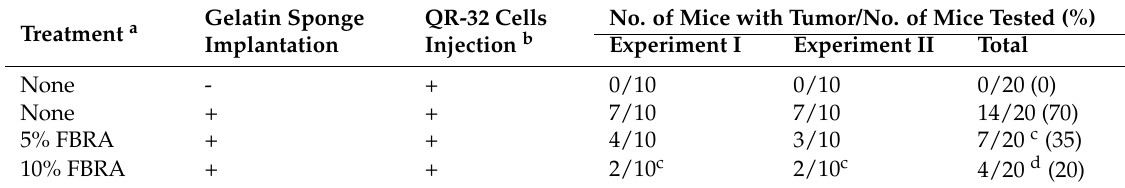
Table 1. Inhibition of inflammation-related carcinogenesis by administration of FBRA.